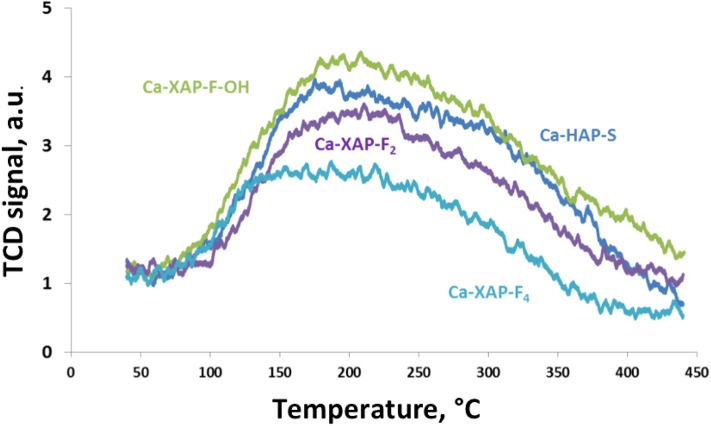
NH3 TPD profiles for Ca-HAP-S and F substituted hydroxyapatites.